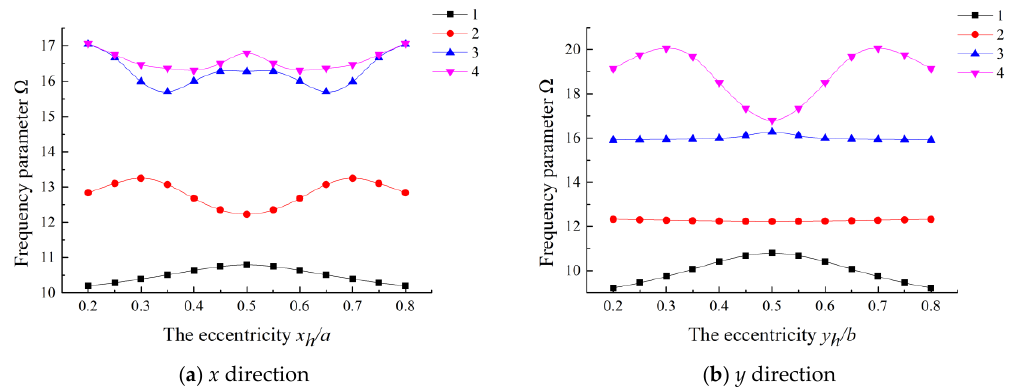
Figure 2. Variation of the frequency parameters for a (0°/90°/0°/90°) laminated rectangular plate with different cutout eccentricity ratios.